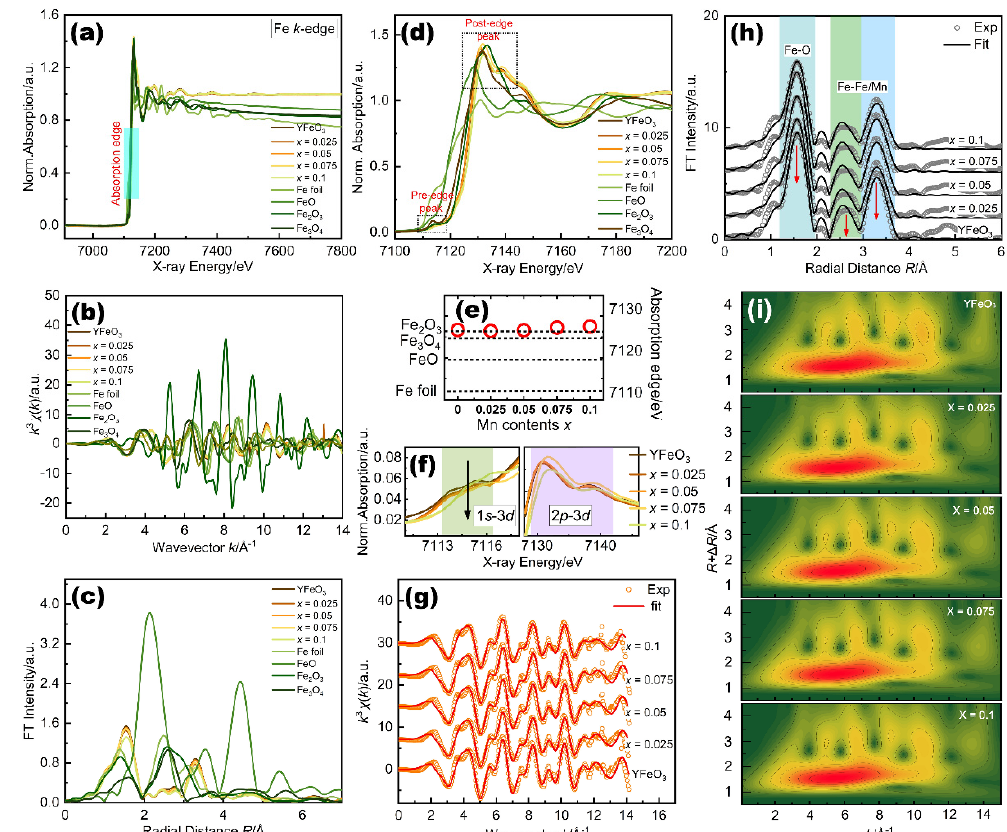
Figure 3. ( a ) Fe K -edge XANES full spectra of YFM x O (0 ≤ x ≤ 0.1) and reference samples; ( b ) EXAFS oscillations of YFM x O and reference samples; ( c ) Fourier transform EXAFS functions of YFM x O and reference samples; ( d ) magnified XANES spectrum; ( e ) composition dependence of the absorption edge E o . The dashed lines represent E o of the reference samples; ( f ) enlarged XANES spectrum of the main peaks; ( g ) EXAFS spectra and best fits; ( h ) Fourier transform EXAFS data and best fits; ( i ) wavelet for the k 3 -weighted EXAFS signals; the data were offset for clarity.